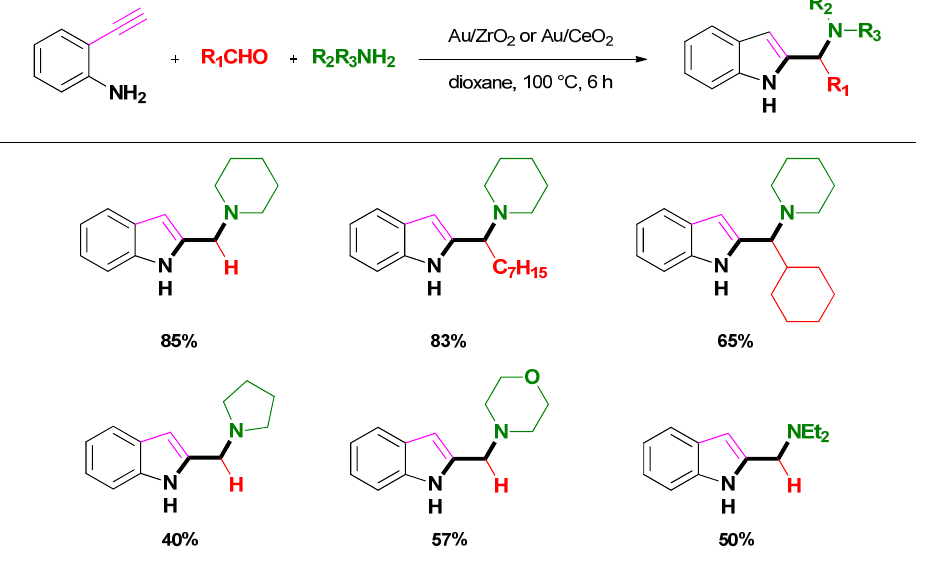
Scheme 16. Three-component one-pot synthesis of indole catalyzed by Au/ZrO Au/CeO following Corma et 2